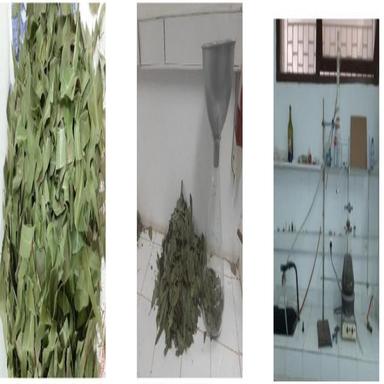
Fresh leaves of E. globulus and hydrodistillation assembly.